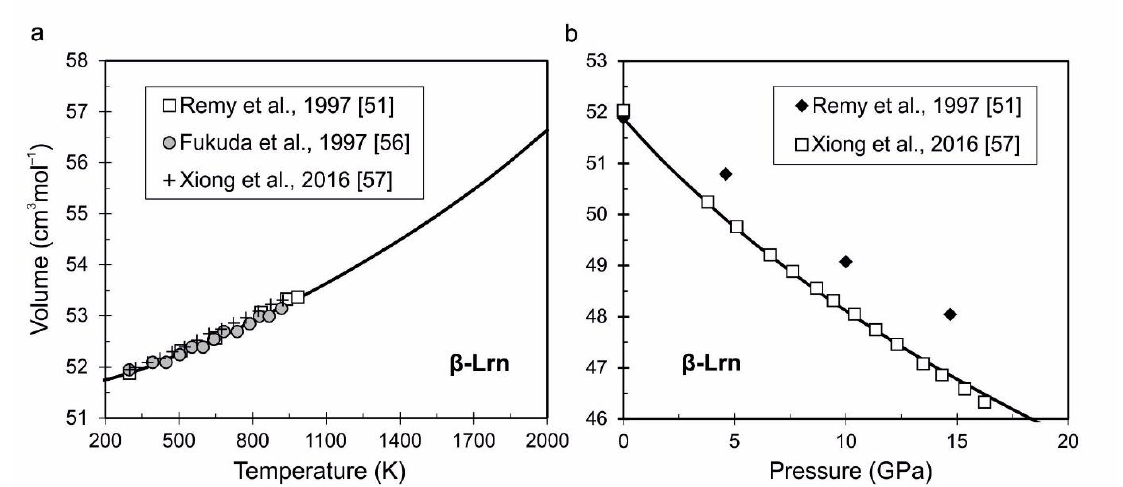
Figure 3. The calculated volume of larnite ( β phase) as a function of temperature ( a ) and pressure ( b ) is compared with experimental data from